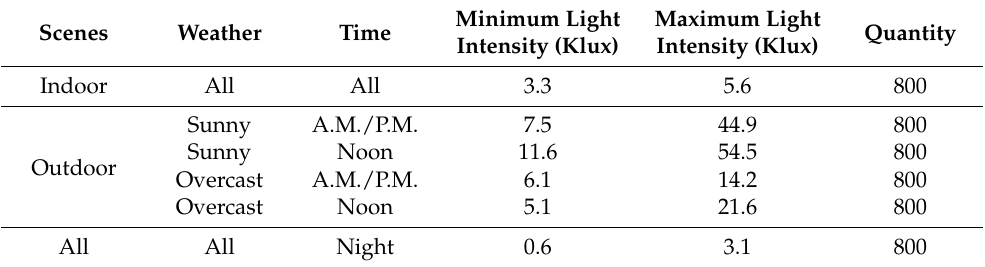
Table 2. Collection of CP data in RPS.